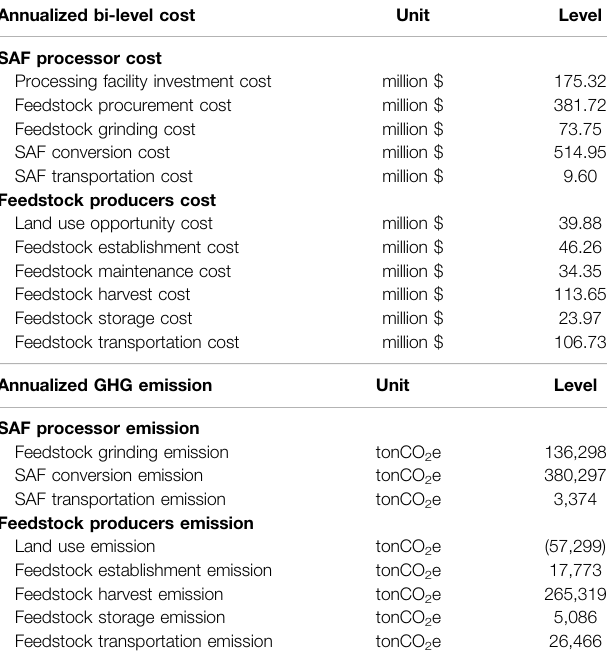
TABLE 4 | Annualized variables for the Baseline.